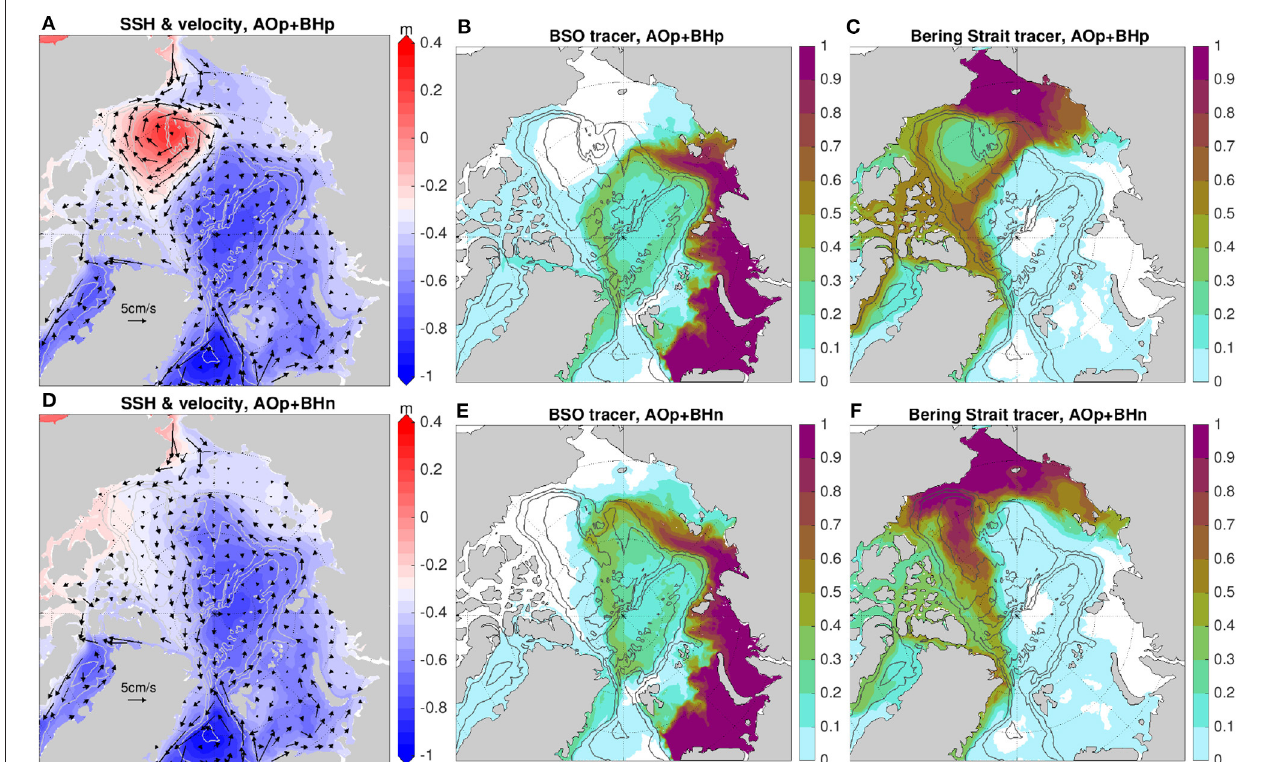
FIGURE 7 | Left: Sea surface height (SSH) and upper 150 m mean velocity in the last model year. Middle column: The upper 150 m mean value of Barents Sea Opening (BSO) passive tracer concentration in the last model year. Right: The upper 150 m mean value of Bering Strait passive tracer concentration in the last model year. (A–C) : the case with positive Arctic Oscillation (AO) forcing and positive Beaufort High (BH) forcing. (D–F) : the case with positive AO forcing and negative BH forcing. The 500, 2,000, and 3,500 m isobaths are shown with gray contour lines.